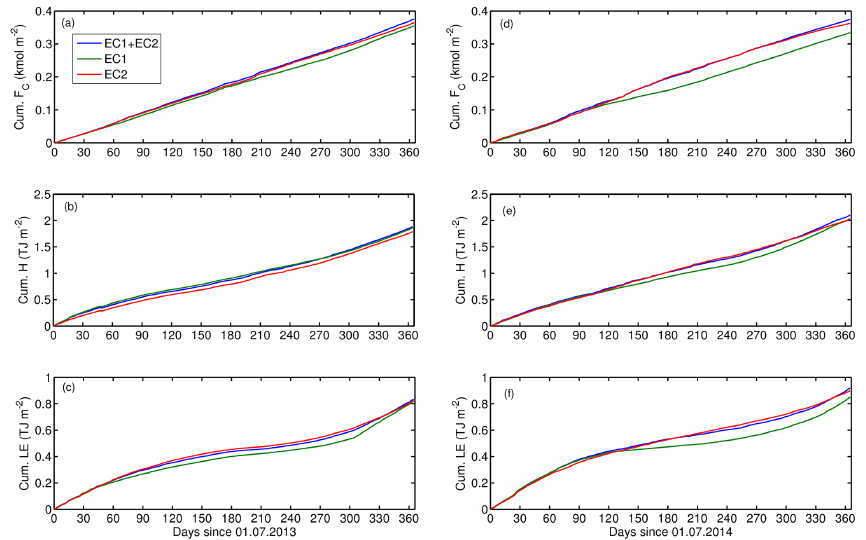
Figure 11. Annual cumulative fluxes of (a, b) CO 2 ( F C ), (b, e) sensible ( H ) and (c, f) latent heat (LE) for different data sets during July 2013–June 2014 (a) – (c) and July 2014–June 2015 (d) – (f) . 1 July. EC1 + EC1 consists of EC1 measurements for the sector 230–340 ◦ , EC2 measurements for the sector 40–150 ◦ and the average of the two systems outside the flow distortion sectors (40–150 ◦ for EC1 and 230–340 ◦ for EC2). The gap filling of each time series is done based on the diurnal variations over a 3-month period around the month, with working days being gapped separately from weekends and holidays. Table 2. Gap-filled cumulative (cum) vertical flux values and percentage of data (%) being gap-filled for two separate years. Fluxes are filtered using either only stationarity (FS < 0 . 3) or stationarity, kurtosis ( K < 1 or K > 8) and skewness ( | SK | > 2). F C : CO 2 flux; H : sensible heat flux; and LE: latent heat flux. See Fig. 11 caption for details for EC1 + EC2, EC1 and EC2. Period Flux Filtering EC1 + EC2 EC1 EC2 cum